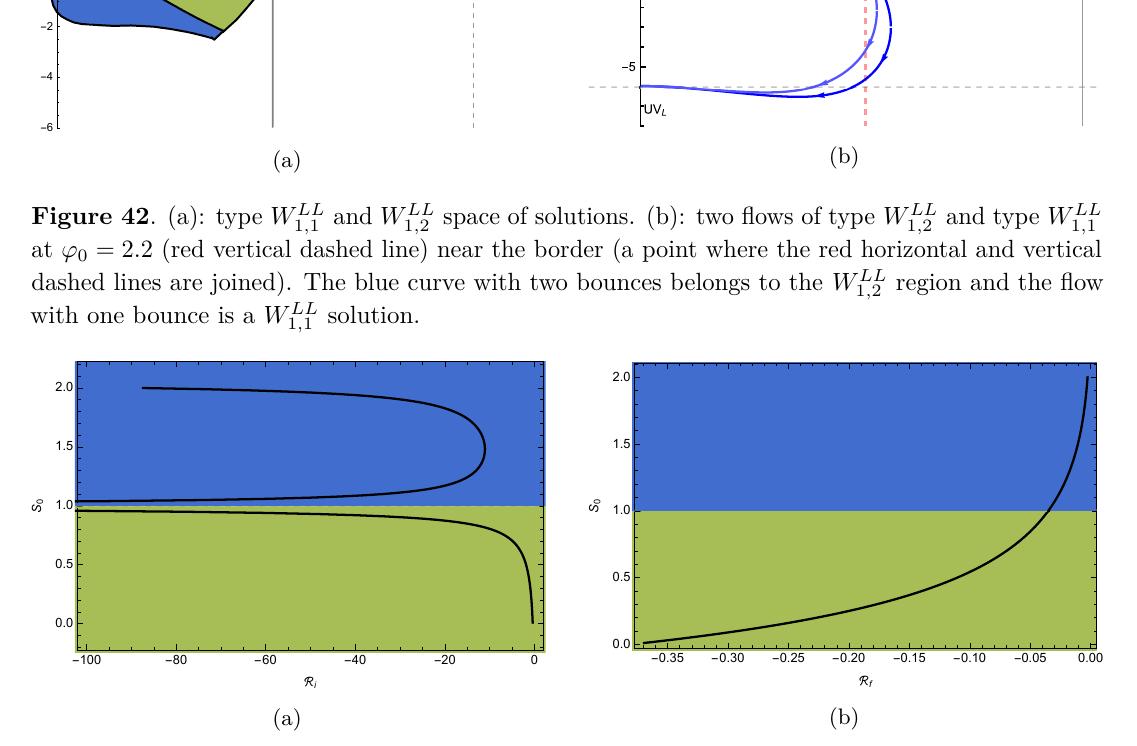
and W LL solutions and their joint boundary. We move from Figure 43 . (a): space of type W LL 1 , 1 1 , 2 region to W LL region on a constant ϕ . (b,c): the behavior of dimensionless curvature R W LL 0 1 , 1 1 , 2 when we cross the boundary from region W LL or W LL on a constant ϕ = 2 . 2 . The horizontal red 0 1 , 1 1 , 2 dashed line denotes the location of the boundary nearly at S 0 . 95 0 ≈